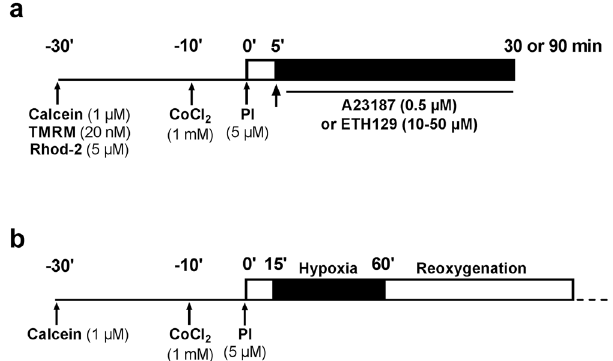
Figure 7. Design of the experiments performed on isolated